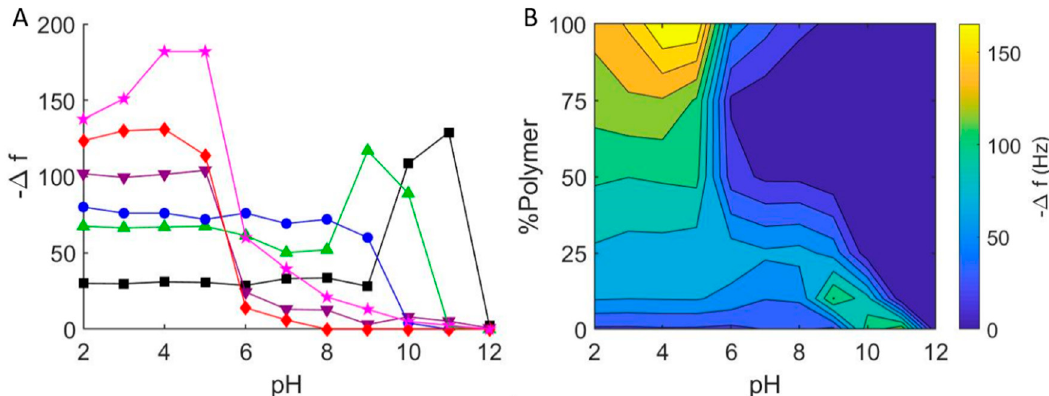
Figure 5. ( A ) Final frequency changes for the interaction of hybrid DOPC / EO 22 Bd 33 vesicles with borosilicate glass at varying pH. 0 mol % polymer (black squares), 10 mol % polymer (green triangles), 25 mol % polymer (blue circles), 50 mol % polymer (purple inverted triangles), 75 mol % polymer (red diamonds), 100 mol % polymer (pink stars). ( B ) Graphical representation of QCM-D measurements of hybrid DOPC / EO 22 Bd 33 vesicles at varying pH. Data points were taken after a stable frequency was reached.